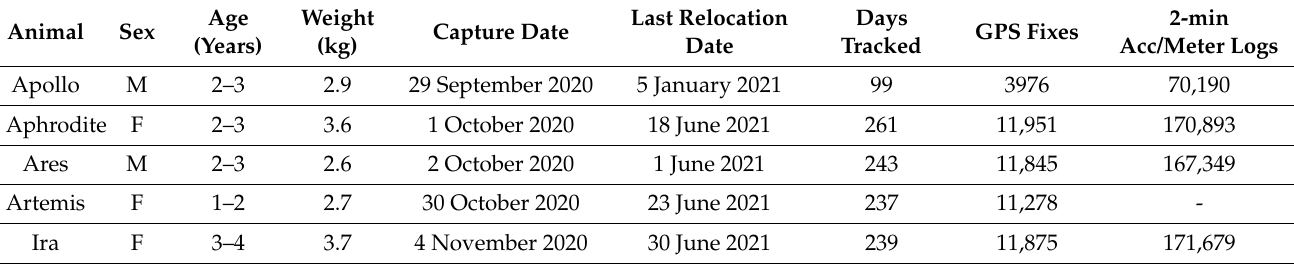
Table 1. Summary table of the tracking period and collected data (GPS locations and accelerometer 2-min logs) for the monitored